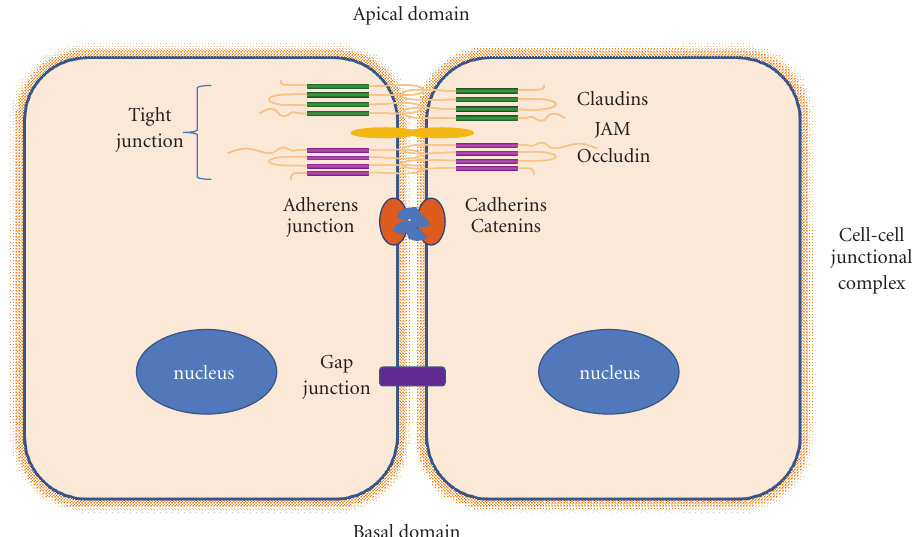
Figure 2: Tight Junctions. Tight junctions are the most apical intercellular junctions in epithelial cells. The major molecular components of the tight junctions are the claudins, occludin, and the junctional adhesion molecule (JAM). Tight junction proteins in conjunction with adheren junction proteins (cadherins, catenins) form epithelial cell junctional complexes [26] . The gap junction is located basal to the adheren